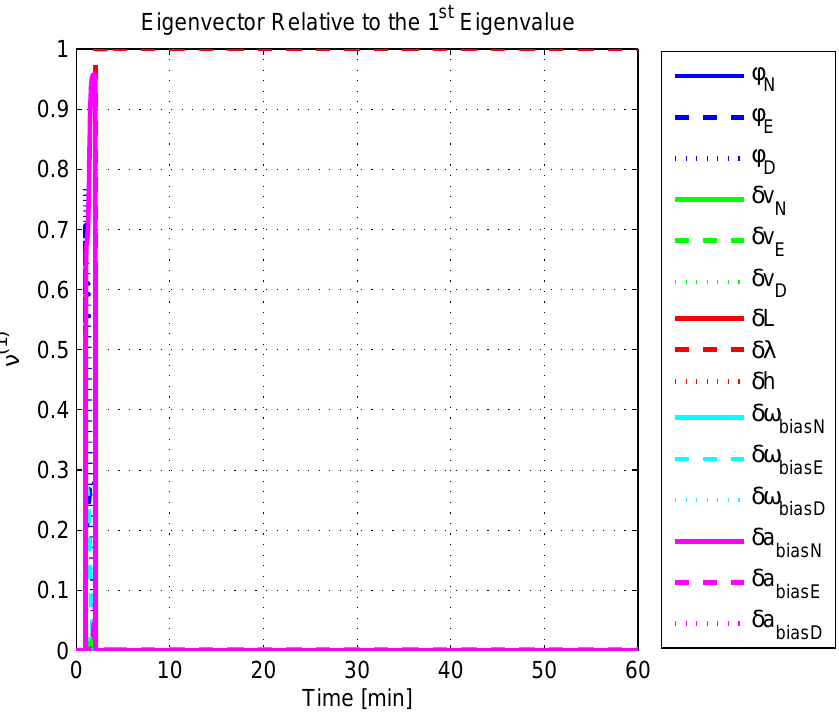
Figure 16. Eigenvector relative to the first eigenvalue in the experimental test.